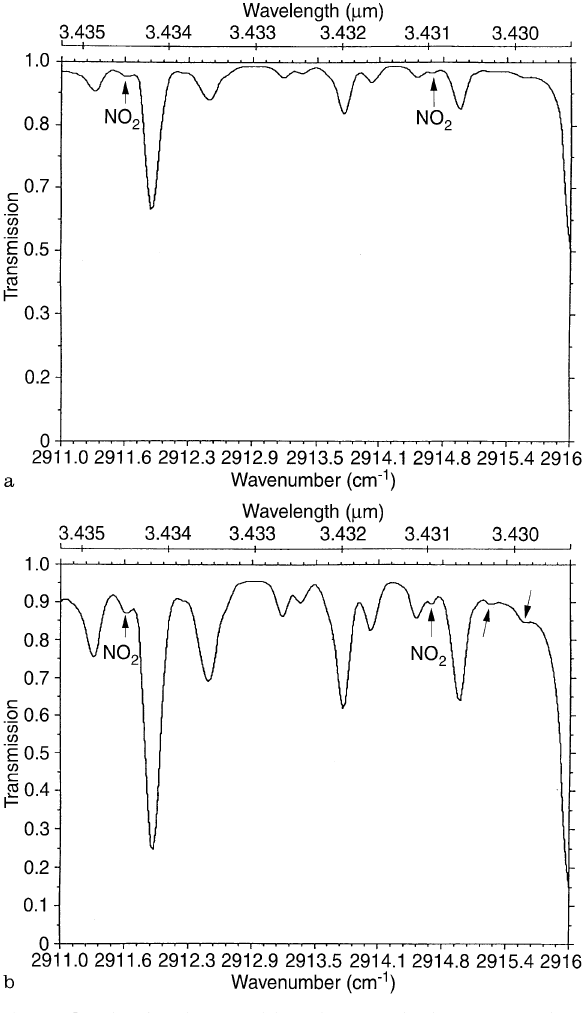
Fig. 6. Simulated atmospheric spectra in the 1598 — 1605 cm (cid:126)(cid:49) spec- tral range containing significant NO (cid:50) absorptions, corresponding to MIRAS measurements at different tangent altitudes ( H " 15, 30 km)